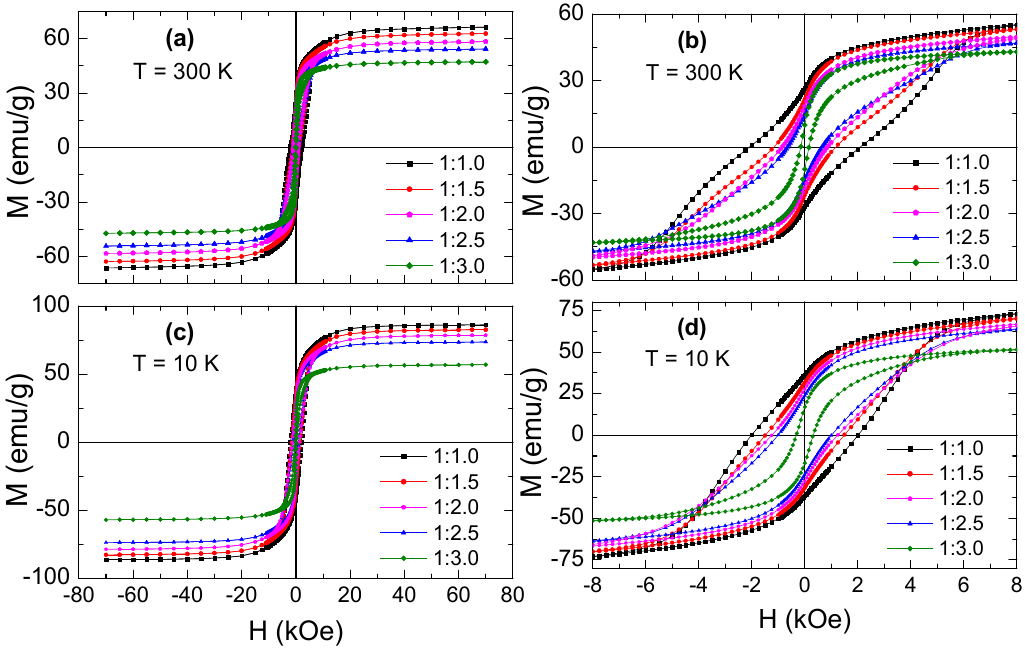
Figure 7. M(H) hysteresis curves performed at ( a , b ) T = 300 K and ( c , d ) T = 10 K for hard / soft ferrite SrBaSmFe / (NiZnFe) x NCs (1.0 ≤ x ≤ 3.0)